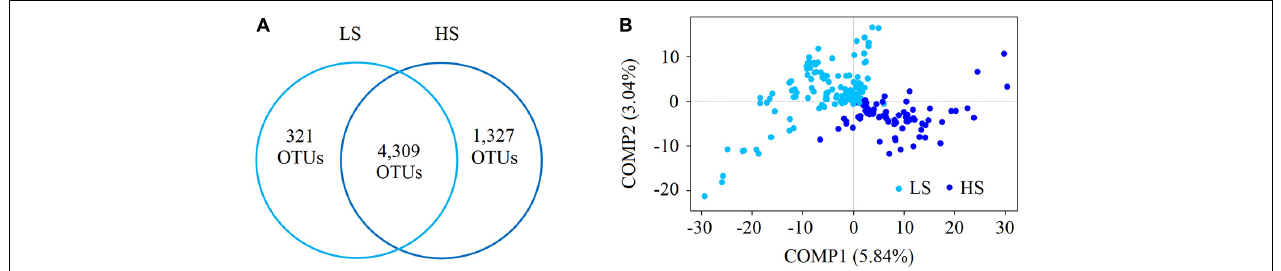
FIGURE 1 | Compare the bacterial diversity of shrimp intestine in the LS and HS groups. (A) Schematic drawing showing the detected shrimp intestine bacterial OTUs found in the LS and HS groups using the Venn analysis. There were 4,309 OTUs shared between the two groups, while 321 and 1,327 OTUs were only in the LS and HS groups, respectively. (B) The PLS-DA of the bacterial community structure of shrimp intestine in the LS and HS groups based on the Bray–Curtis distance, and the results showed marked differences in the two groups.